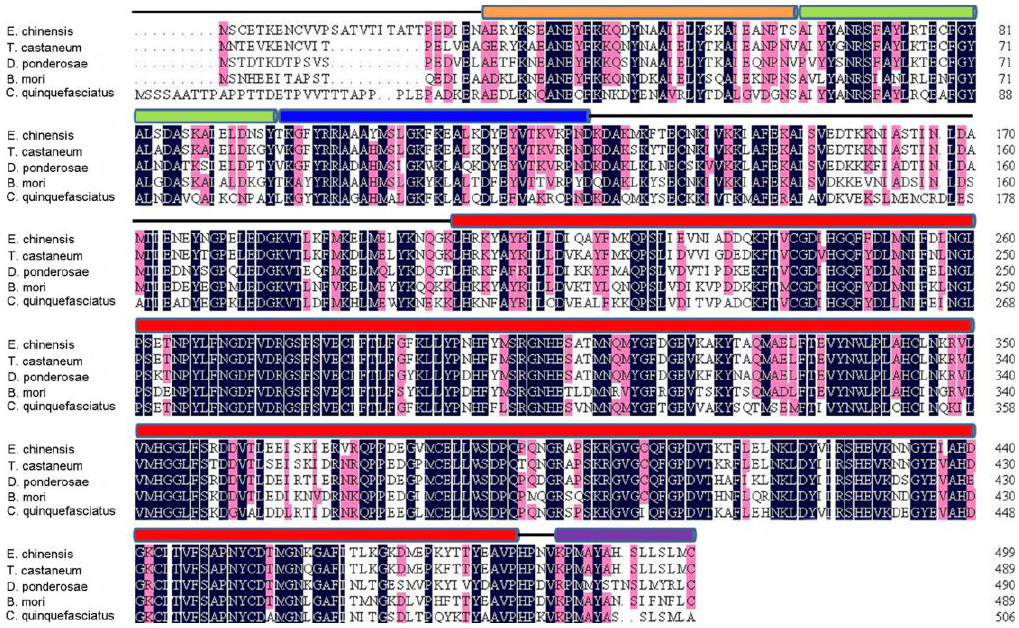
Figure 1. Amino acid sequence comparison of insect Protein phosphatase 5 (PP5s). Alignment of the deduced amino acid sequence of Ec PP5 was made with other insect PP5s from Tribolium castaneum (accession number XP 971407), Dendroctonus ponderosae (accession number AEE62915), Bombyx mori (accession number XP 004923376), and Culex quinquefasciatus (accession number XP 001850926). The positions of the three TPR (tetratricopeptide repeat) domains are indicated with lines of orange, green, and blue above the sequence. The catalytic domain and helix αJ motif are indicated with a red line and purple line above those sequences,